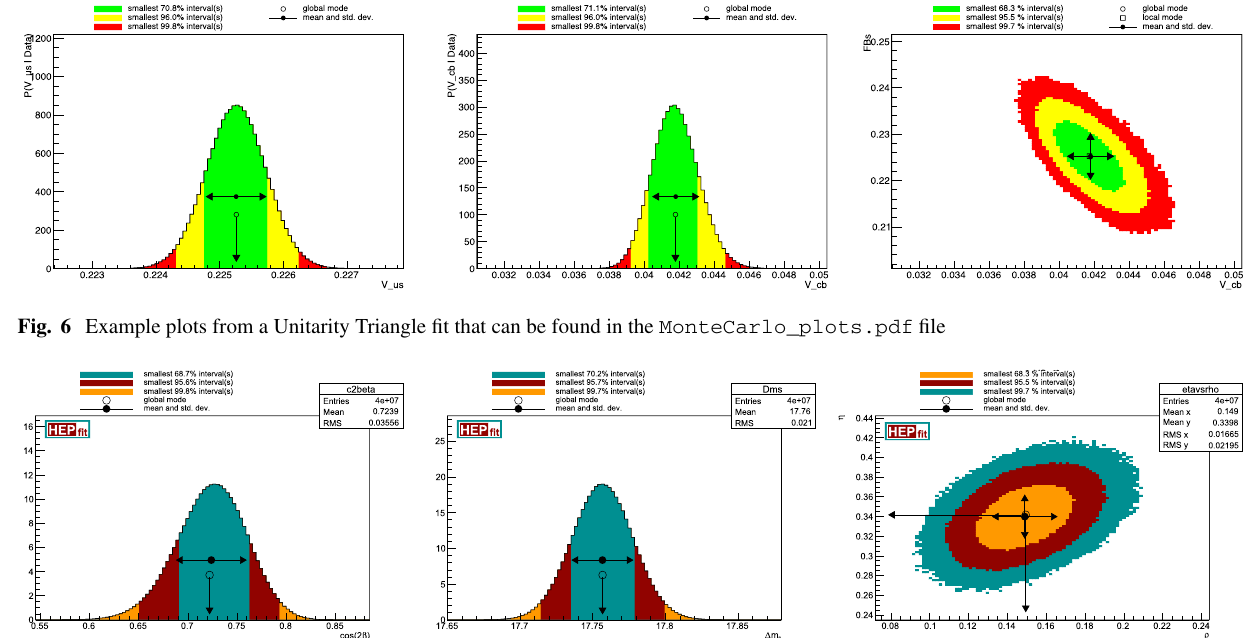
Smallest interval containing 68.0% and local mode: (0.22481 , 0.225745) (local mode at 0.225278 with rel. height 1; rel. area